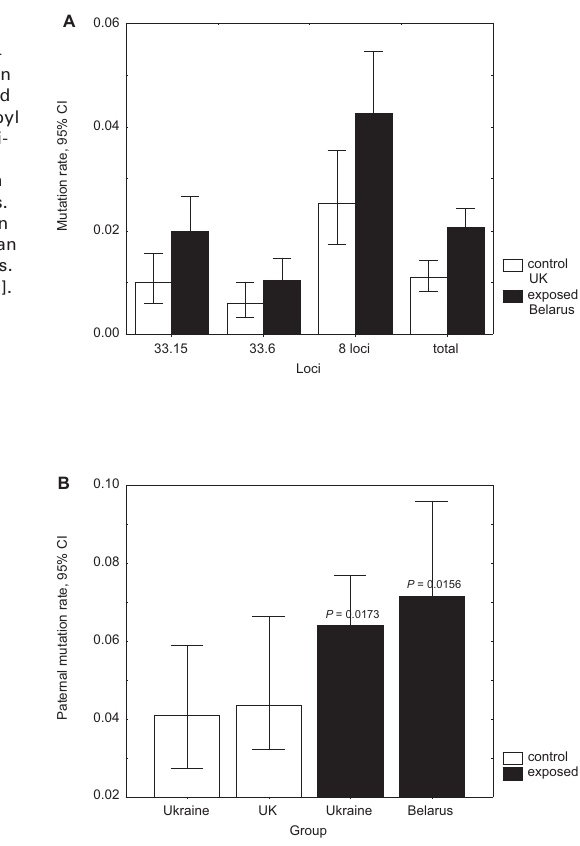
Figure 1 Germline minisatel- lite mutation rates in the families exposed to the post-Chernobyl radioactive contami- nation. A. Mutation rates in the Belarus families. B. Paternal mutation rates in the Ukrainian and Belarus families. Data from [7, 24, 25]. The probabilities of difference from the control group (Fisher’s exact test, two-tailed) are